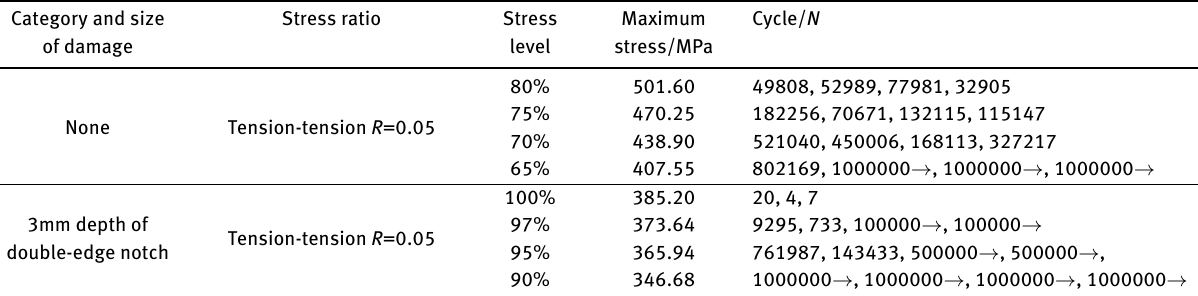
Table 4: Fatigue results of 3238A/CF8652 laminate Category and